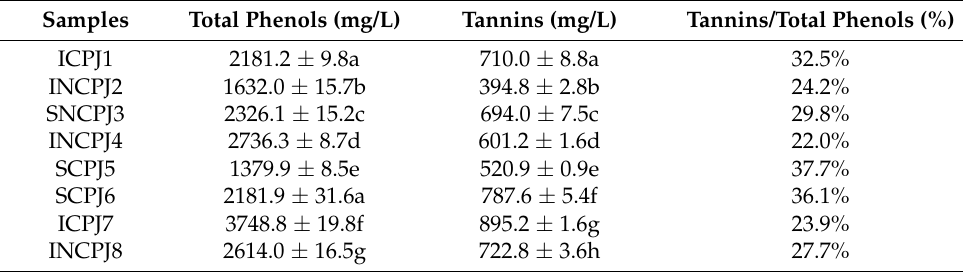
Table 2. Total phenols, tannins, and their ratios contained in the eight PJs. Samples Total Phenols (mg/L) Tannins